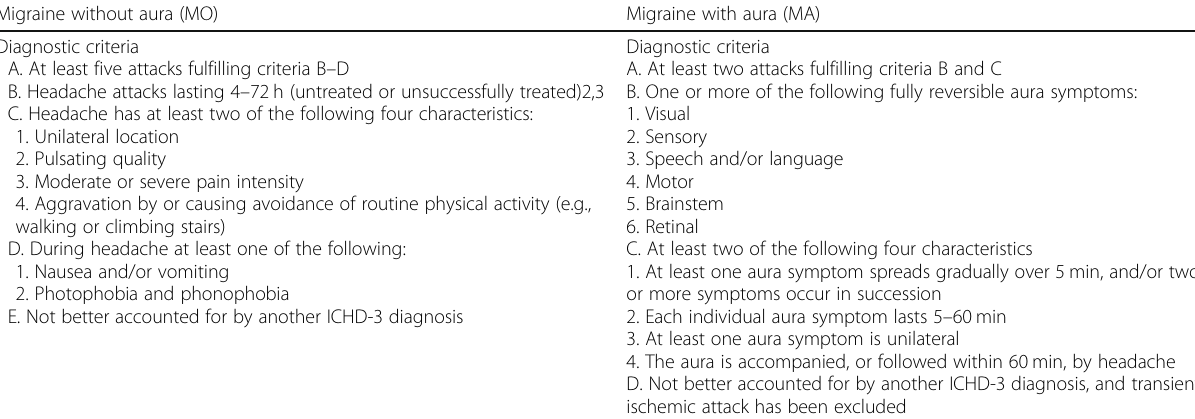
Table 1 International classification of headache disorders 3rd edition [9] Migraine without aura (MO) Migraine with aura (MA) Diagnostic criteria A. At least five attacks fulfilling criteria B –